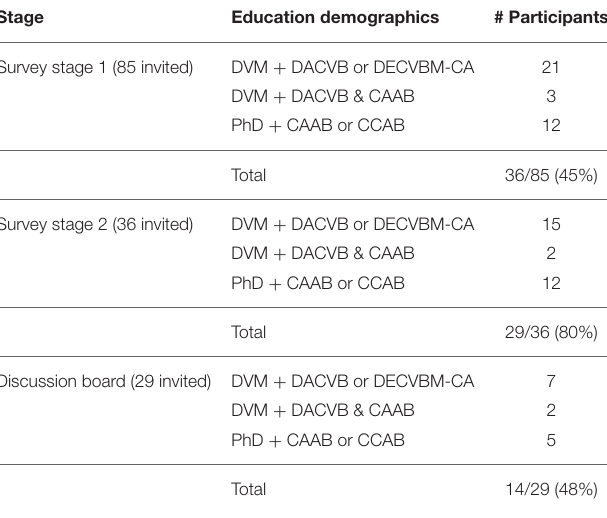
TABLE 1 | Educational demographics of participants in each stage of the survey and discussion